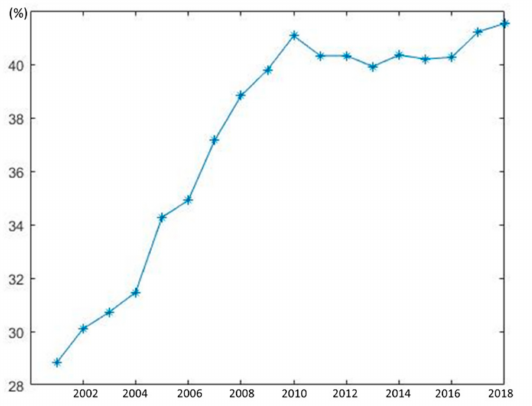
Figure A7. Time series of annual mean green space ratio from 2001 to 2018 in eastern China. Data are from the China City Statistical Yearbook of 2002 to